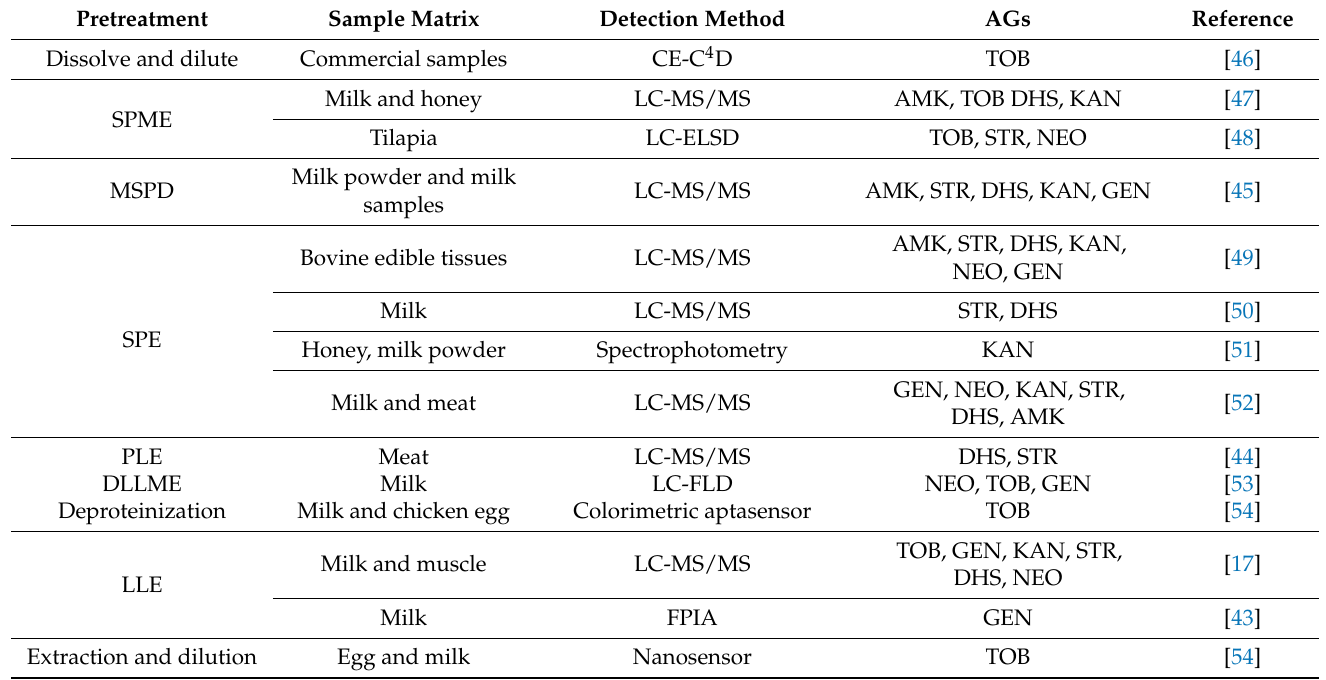
Table 2. Sample pretreatment methods for AGs residue